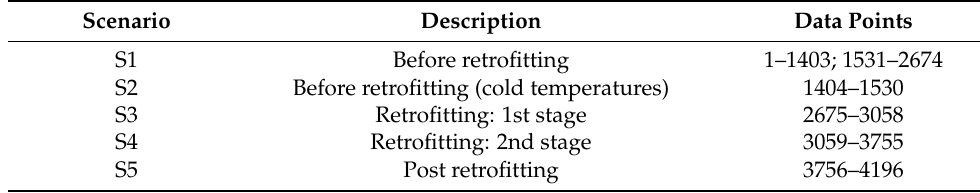
Table 1. Description of the different analyzed